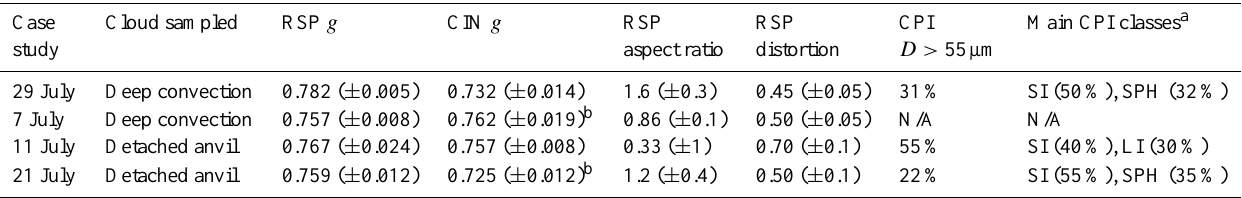
Table 1. Median retrieved asymmetry parameters from RSP and CIN, median aspect ratios and median distortion from the RSP, CPI areal fraction of particles larger than 55µm, and CPI classifications dominating particle area. Interquartile ranges are given in brackets.